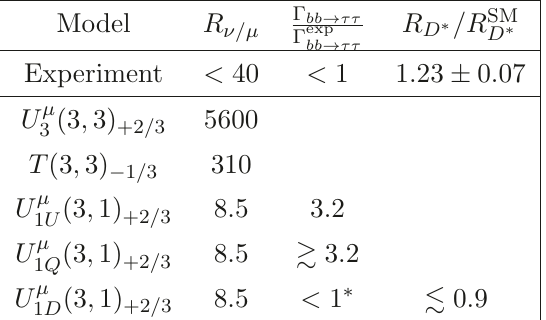
anomaly. K ( ∗ ) in section 4.3. A super-index D ( ∗ ) ∗ . 1 / 8